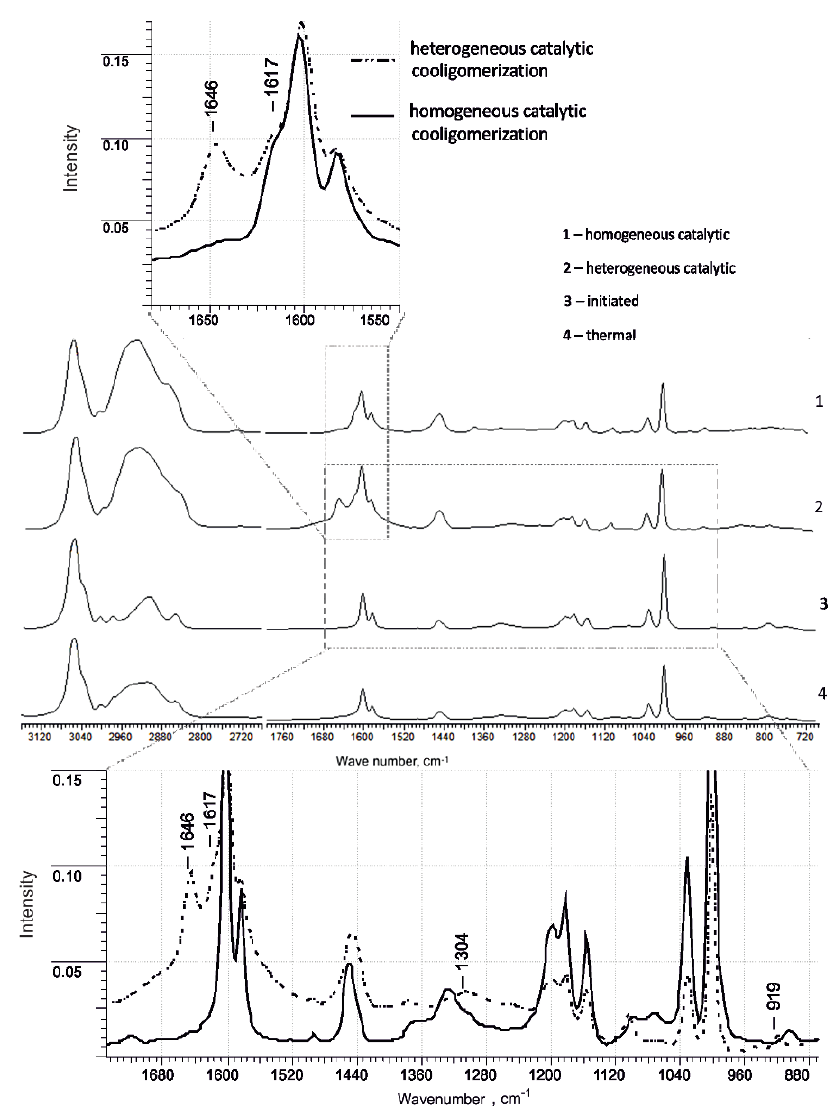
Figure 8. Comparison of Raman spectra of the cooligomers synthesized by different cooligomerization